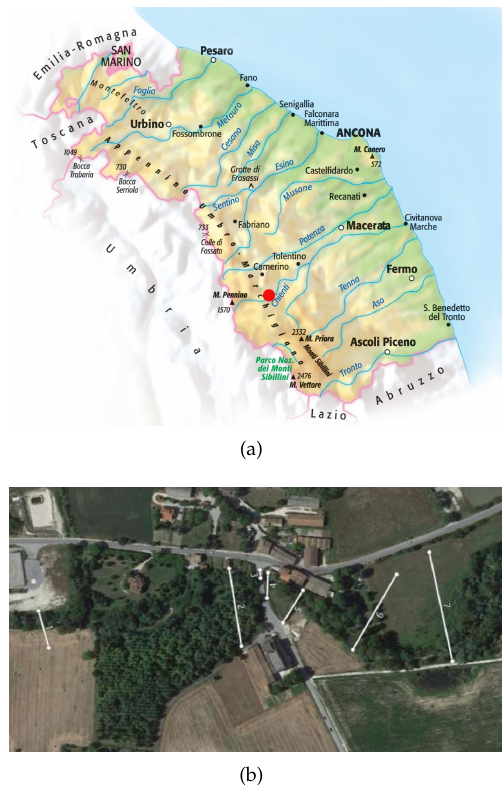
Figure 12. Information about the station located along the Chienti River in the village of Pontelatrave. ( a ) Marche Region, where the red dot indicates the investigated area of the Chienti River near the village of Pontelatrave, in the municipality of Pievebovigliana. ( b ) Schematization of the Chienti River and sections surveyed in the study area.